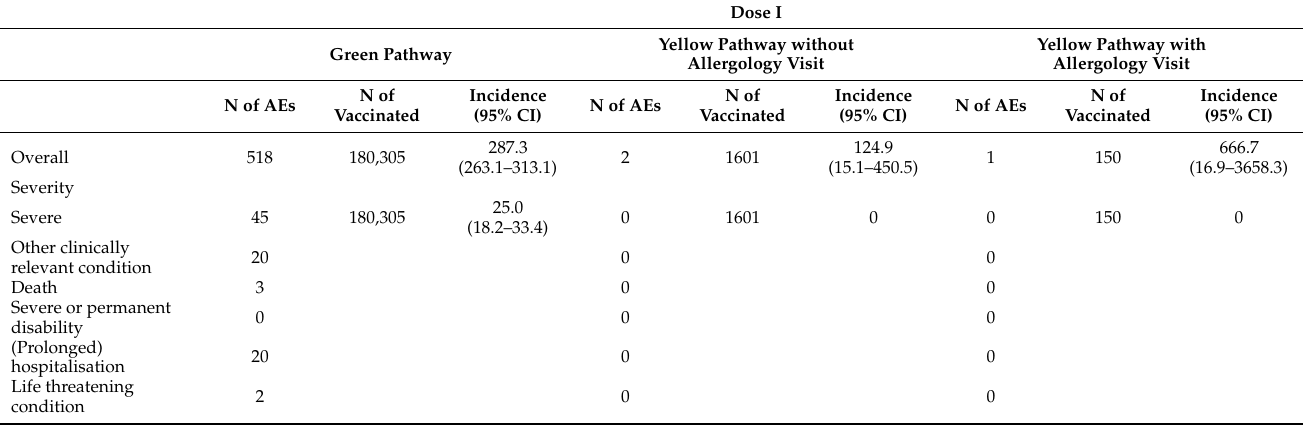
Table 2. Characteristics of adverse events after the first dose of COVID-19 vaccine, by risk pathway. Dose